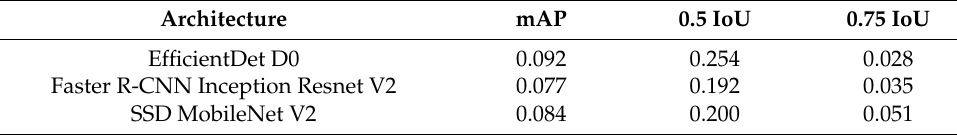
Table 12. The object detection evaluation on the Tiling Mock Attack Dataset.